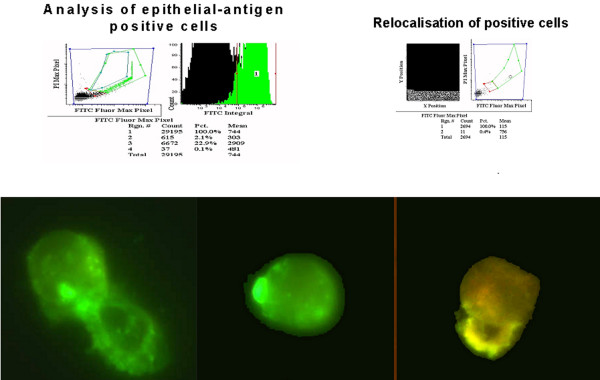
Fluorimetric analysis, relocalization and fluoromicrograph of individual circulating tumour cells. Shown are the procedure for quantification and visual control (1 hour for cell preparation and analysis) and three typical viable circulating tumour cells (green fluorescing cap). One cell is also stained for oestrogen receptor (orange fluorescence).